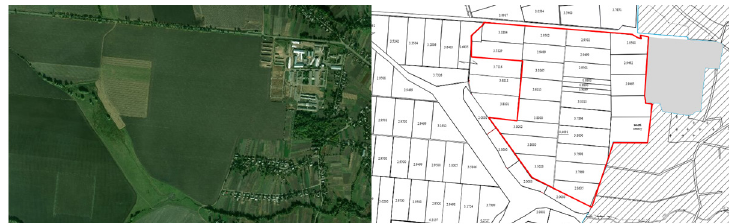
Figure 7. Land plots placement and usage within the third land mass (source: https://map.land.gov.ua/)